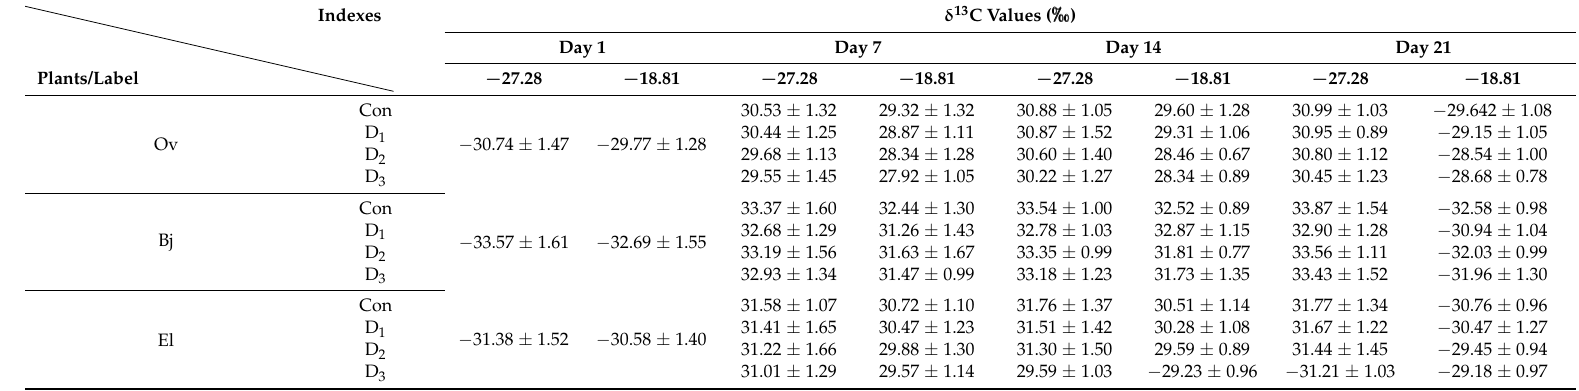
Table A3. Effect of different levels (Con: 25% moisture, D 1 : 17% moisture, D 2 : 14% moisture, and D 3 : 11% moisture) of drought stress on the δ 13 C values for three plant